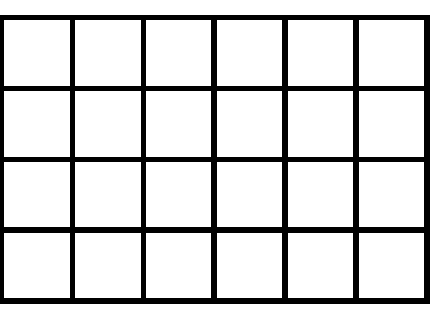
Figure 1. Multiplicative